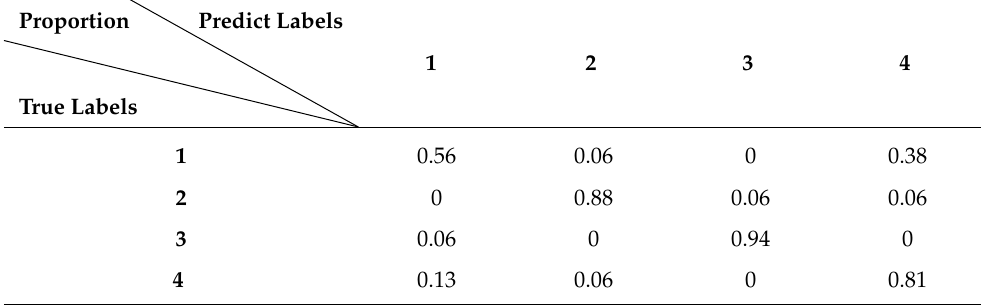
Figure 10. Feature extraction results of CNN-1D and the proposed method on subject HRV data. ( a ) The distribution of the features output by the CNN-1D model after T-SNE dimensionality re- duction. ( b ) The distribution of the features output by the proposed method after dimensionality reduction by T-SNE. Table 6. The classification confusion matrix of the proposed method for psychological stress states. The data in the table is the proportion of the number of samples predicted to be this label in all samples of this